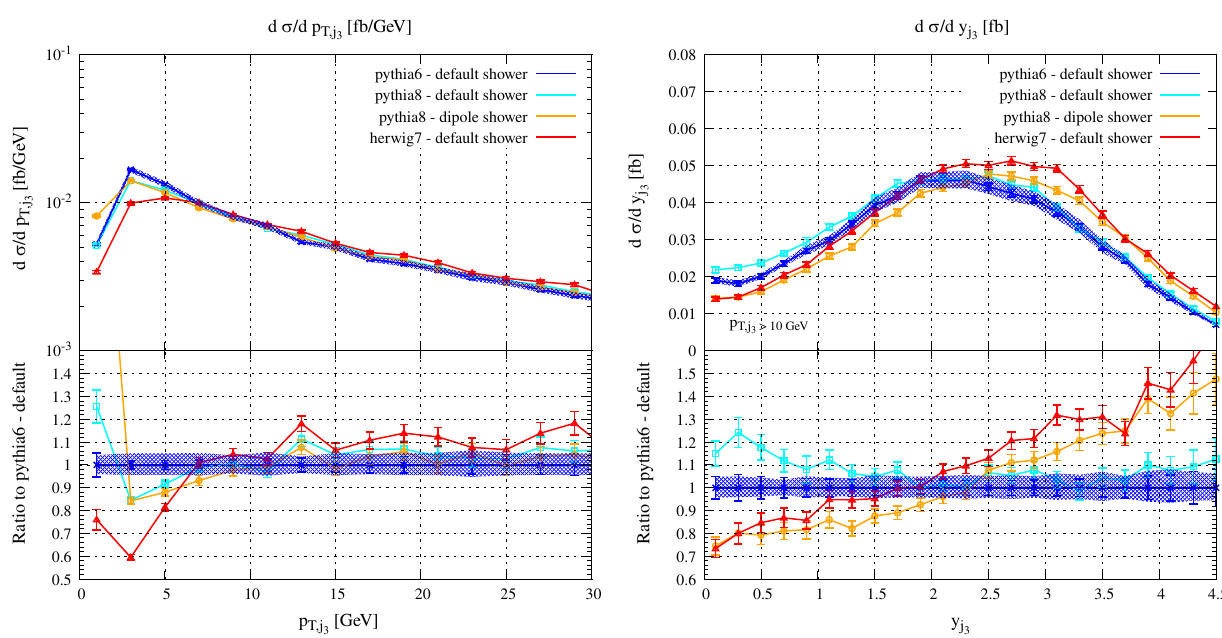
each case the blue bands indicate the scale uncertainty of the PYTHIA6 simulations, statistical uncertainties are denoted by error bars